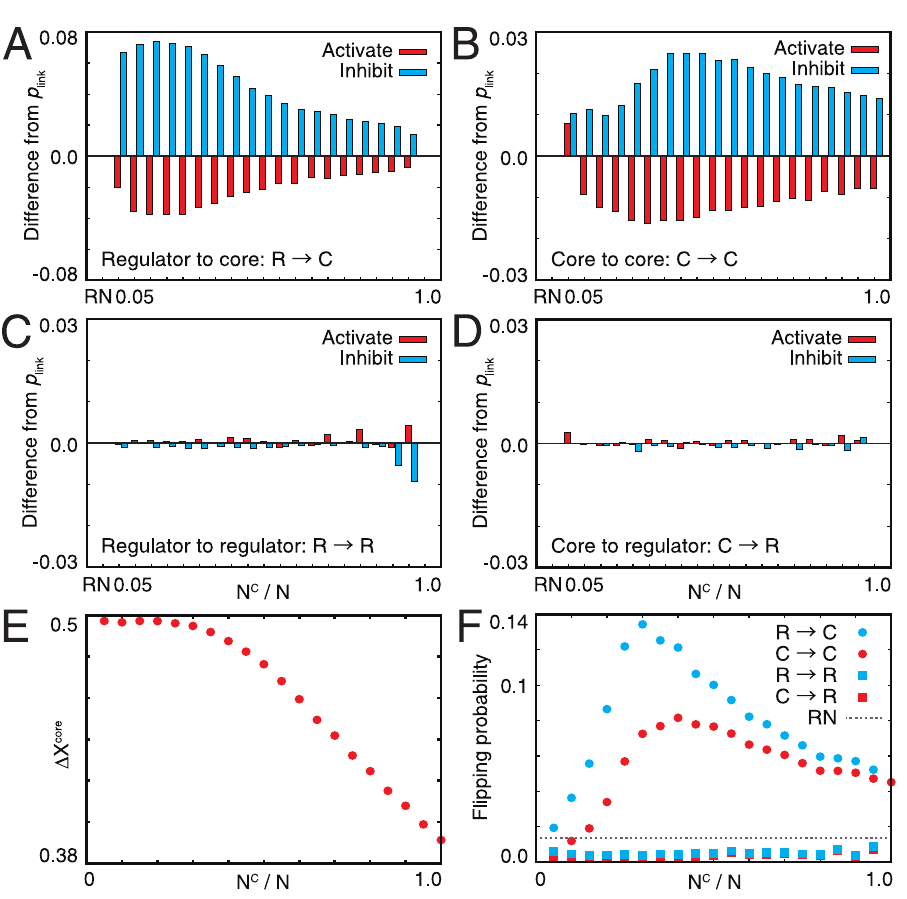
Fig 3. Interactions between the core and regulator genes in evolved networks with varied N C . (A–D) Difference of the linking probabilities between two nodes in the evolved networks from the default value p link . RN indicates the random network. Each graph shows the linking probabilities (A) from the regulator to the core, (B) from the core to the core, (C) from the regulator to the regulator, and (D) from the core to the regulator. Red and cyan bars represent the linking probability for activating and inhibitory interactions, respectively. (E) Δ X of the core without every interaction from the regulator. (F) Flipping probabilities of each node from the off to on state or from the on to off state after a change in the sign of h . Each flipping probability is averaged for every node. Cyan circles and squares i represent the flipping probabilities of nodes in the core and the regulator for a change in a node in the regulator, respectively. Red circles and squares represent these flipping probabilities for a change in a node in the core, respectively. The gray dotted line represents the flipping probability measured for the random network.